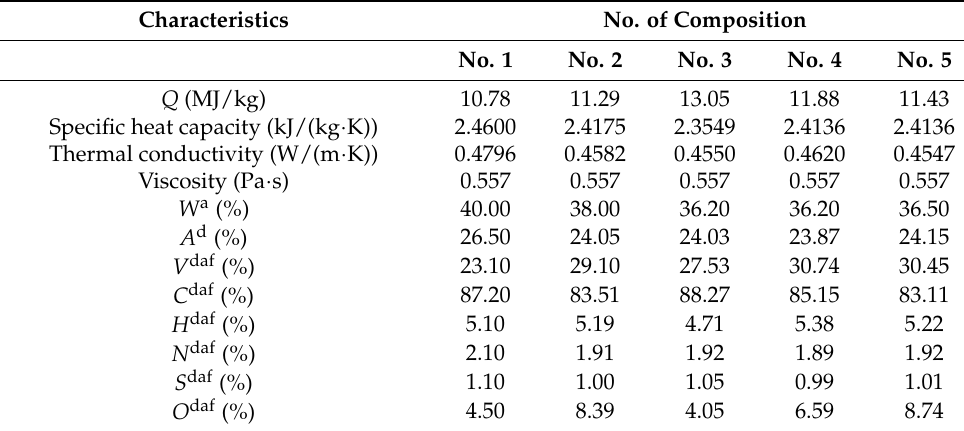
Table 6. The main characteristics of different CLF compositions.